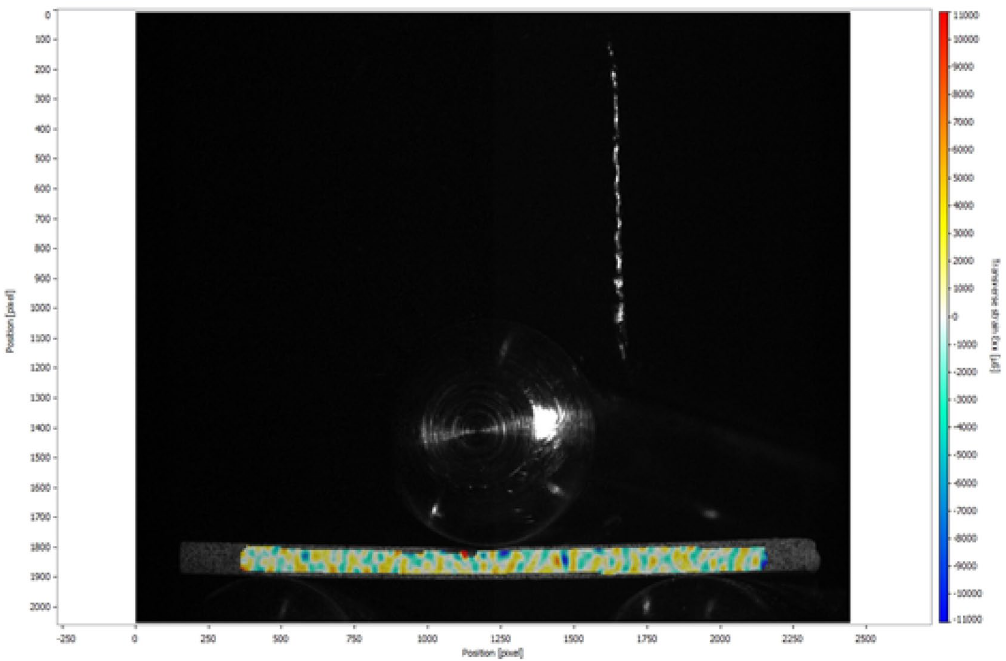
Figure 3. Horizontal strains (Exx) in microstrain (µs) generated during the three-point flexural strength test of the GSG.